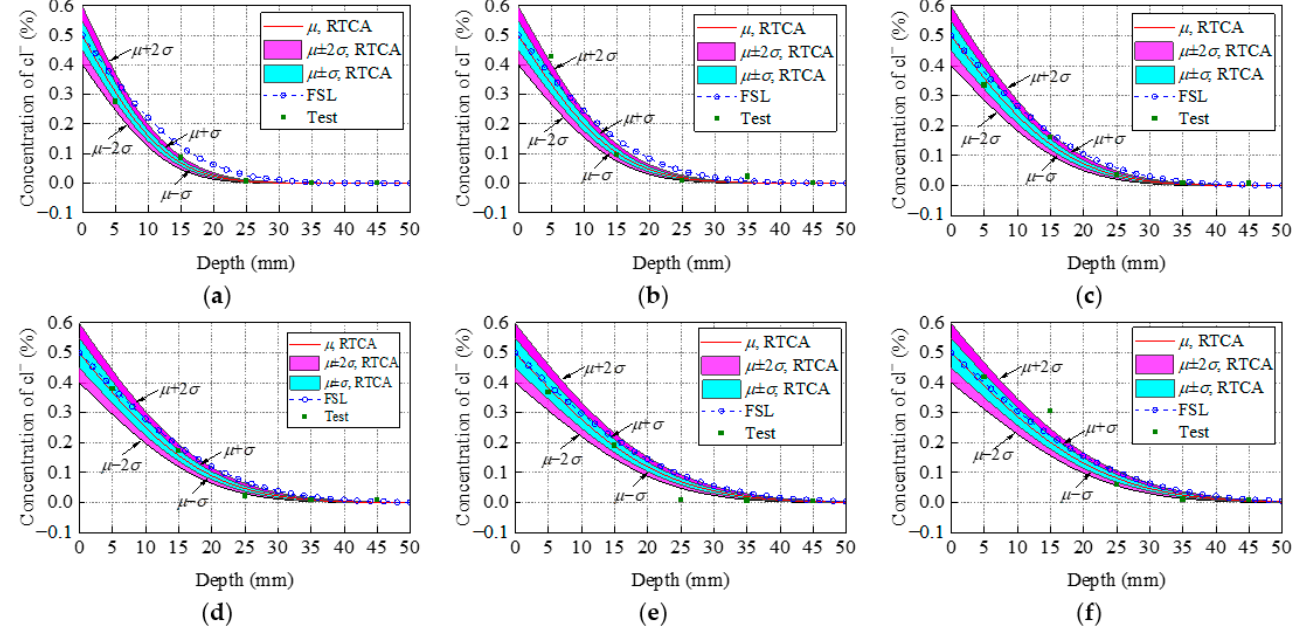
Figure 9. Comparisons between the statistical result µ , σ using the 3D RTCA model, FSL analytical solution, and test data for fly ash concrete: ( a ) t = 0.5 year; ( b ) t = 1 year ( c ) t = 2 years; ( d ) t = 3 years; ( e ) t = 6 years; ( f ) t = 8 years.